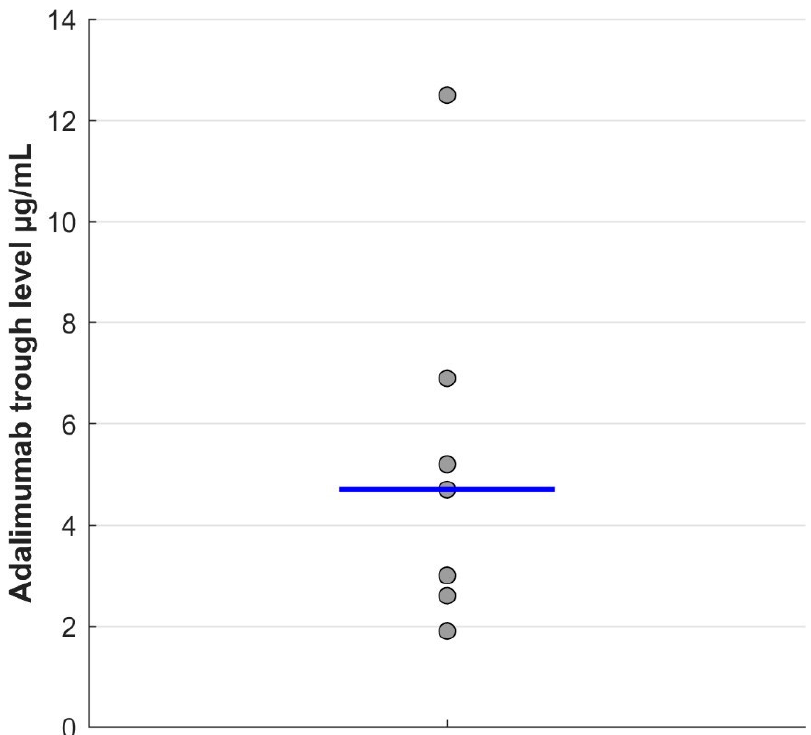
Figure 1. Adalimumab trough levels were measured after a median period of 18 months (range: 4–43) after starting DS. The blue line indicates the distribution median.